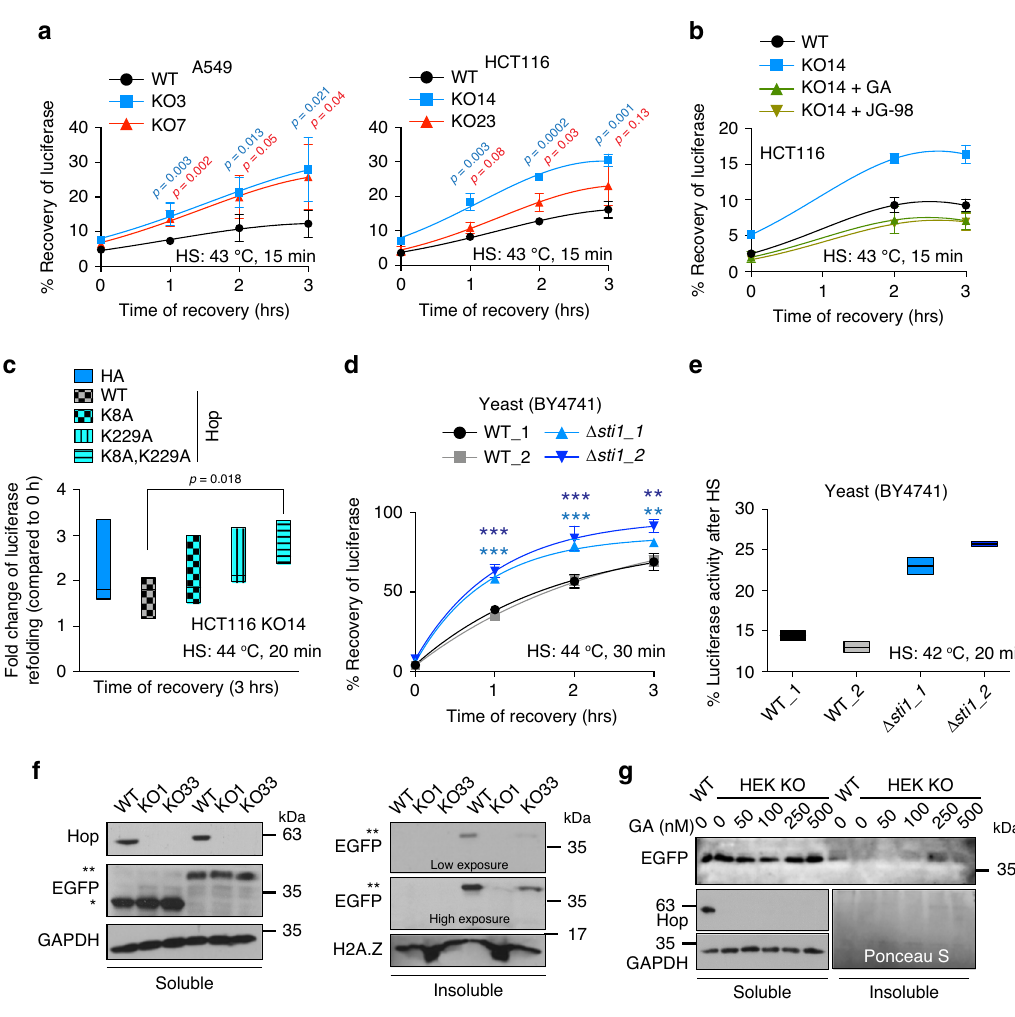
Fig. 6 Hsp70 and Hsp90 are functional in vivo even without Hop. a In vivo refolding of heat-denatured luciferase. Luciferase activity before HS is set to 100%. Left panel, n = 4; right panel, n = 3 biologically independent samples. b In vivo luciferase refolding in HCT116 KO cells treated with inhibitors before and during the recovery phase ( n = 3 biologically independent samples). c In vivo luciferase refolding in HCT116 KO cells exogenously overexpressing WT or TPR mutants of Hop. Non-HS controls for each sample are set 1-fold ( n = 4 biologically independent samples). d In vivo refolding of heat-denatured luciferase in WT and Δ sti1 yeast cells (BY4741 strain background; two different transformants each). *** p < 0.001 and ** p < 0.01 statistically signi fi cant differences between WT and Δ sti1 ( n = 4 biologically independent samples). e Residual in vivo luciferase activity immediately after mild HS ( n =